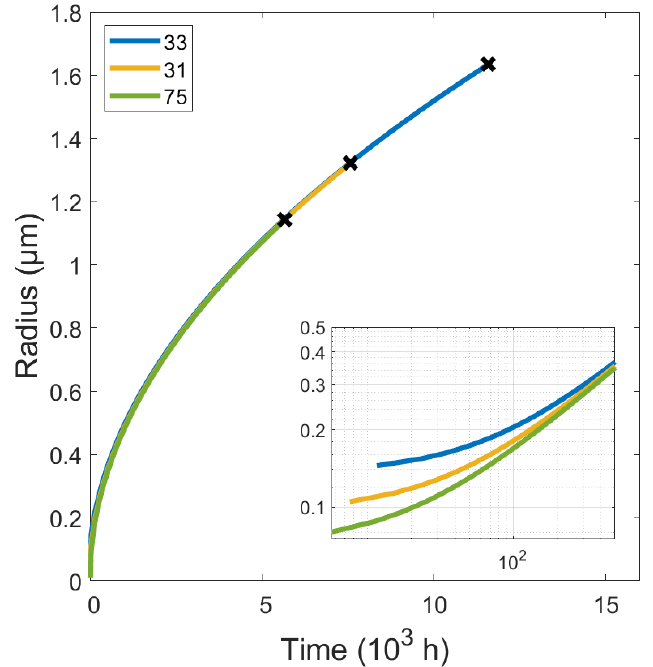
Figure 8. Simulated growth of cavity radii vs. time for the creep conditions of specimens 31, 33 and 75. The x marks the rupture time and end of the simulation. The inset shows the early stage of growth on logarithmic axes. Table 7. Nominal nucleation rates and number of nucleation sites.